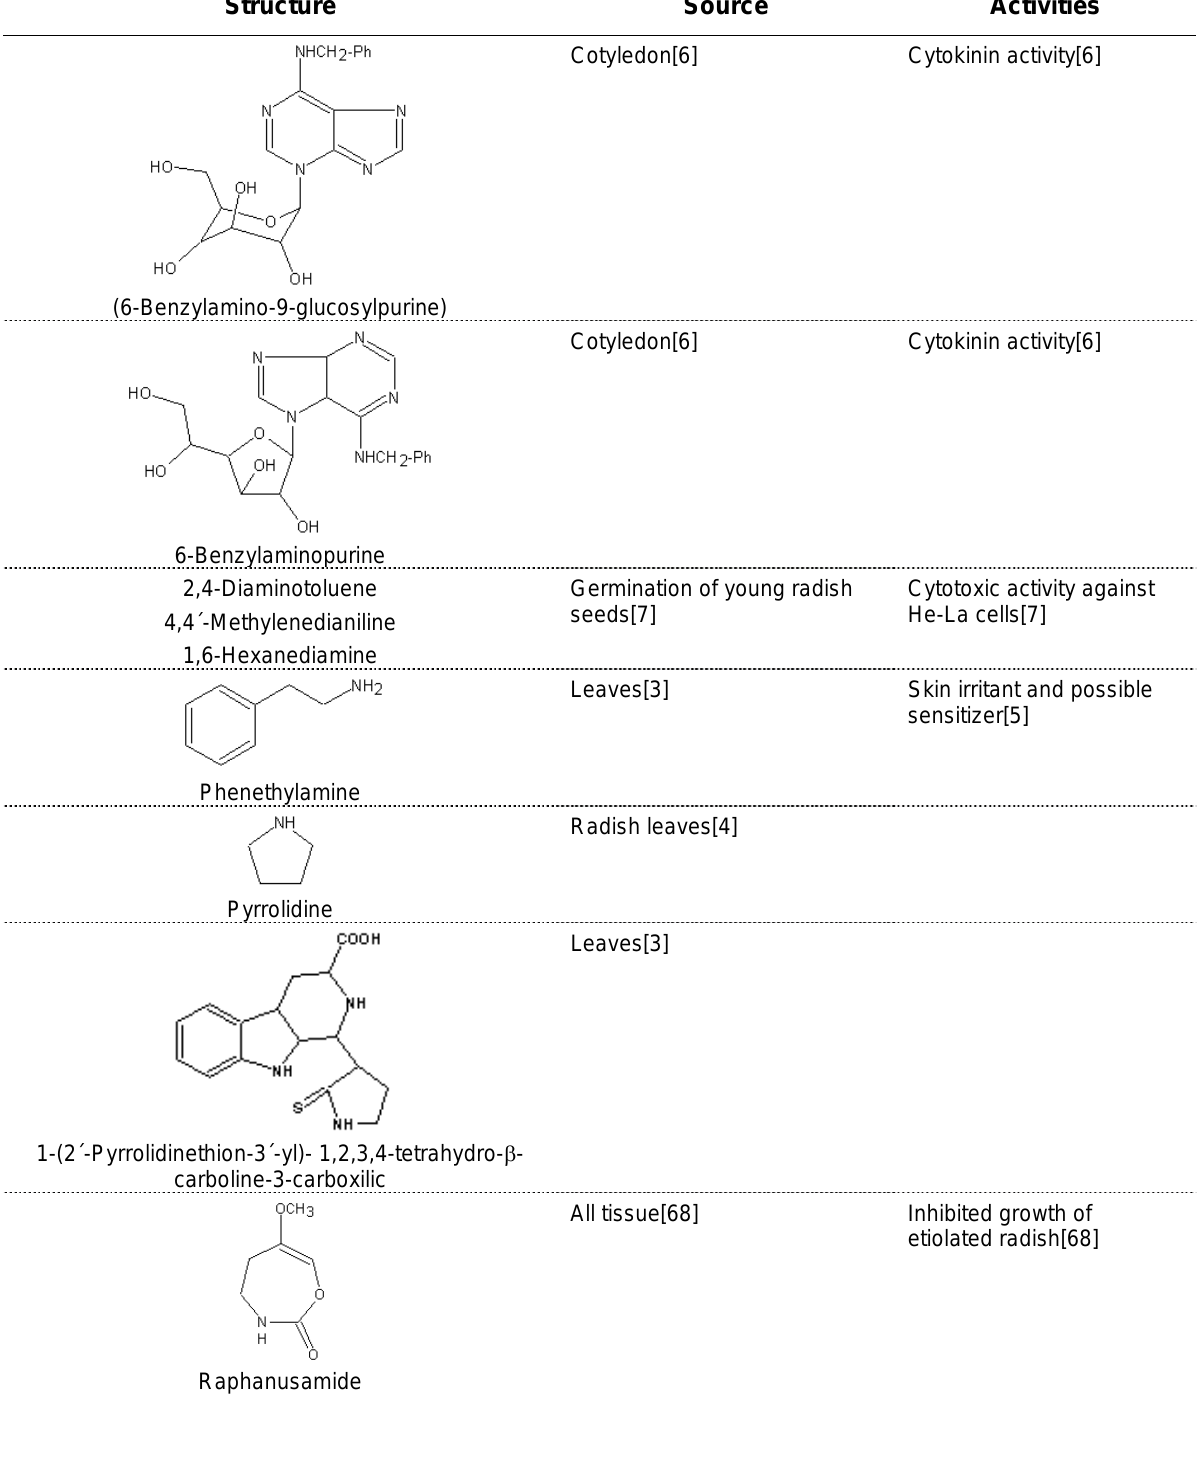
Alkaloids and Nitrogen Compounds Isolated from Radish Structure Source